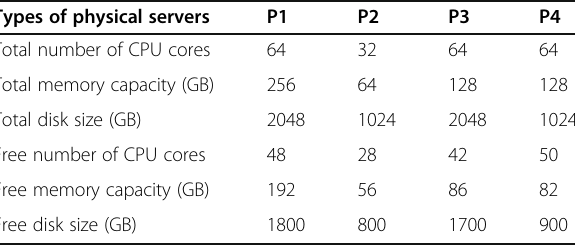
Types of physical